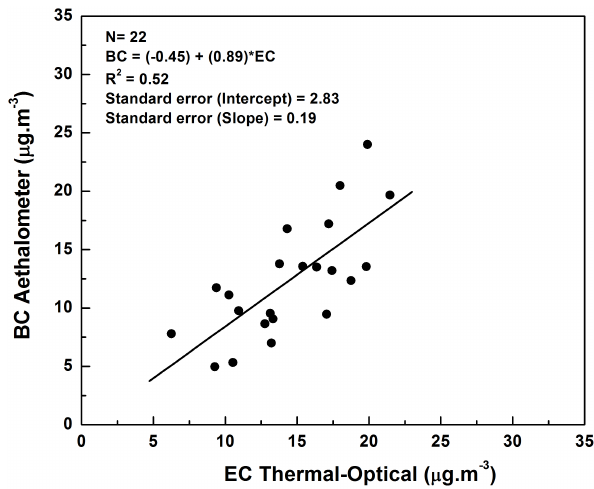
Fig. 4. Comparison of BC measurements (from Aethelometer) and EC measurements (from thermal-optical analyzer) at village center (VC) located in Surya Village (SVI 1).